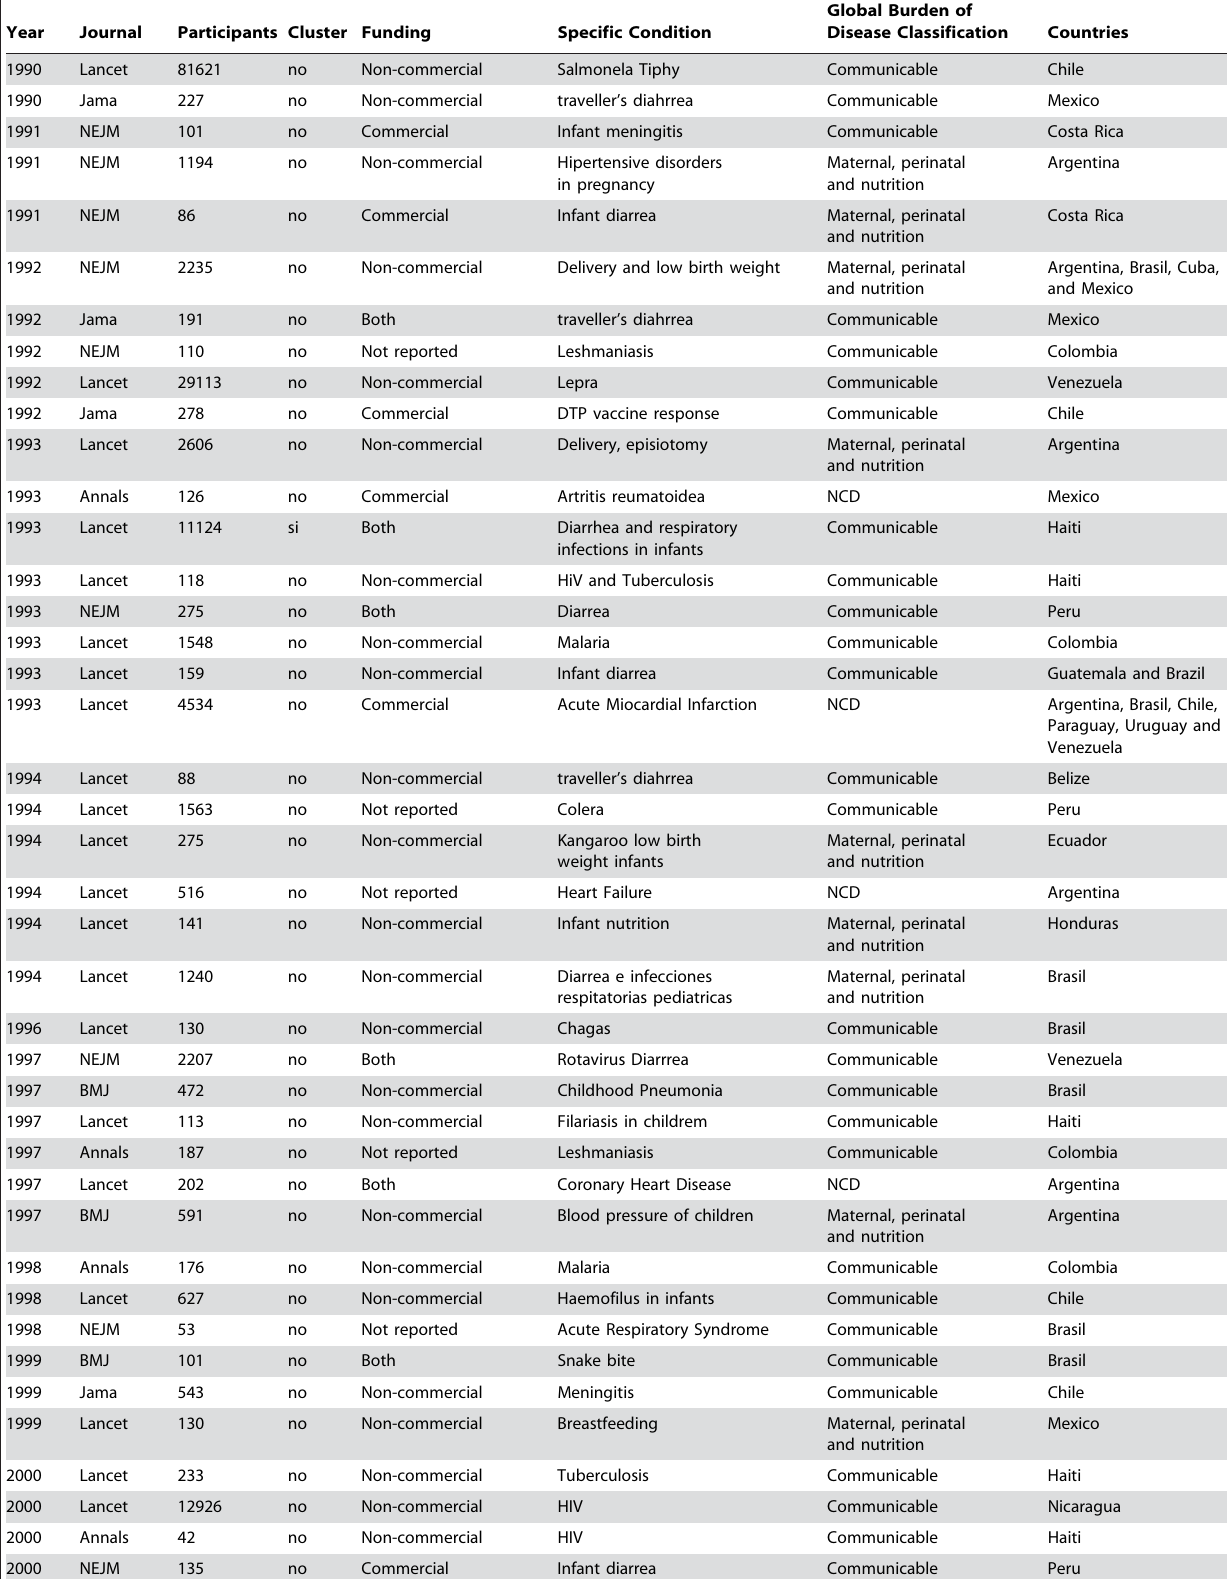
Table 2. Full details of the included reports